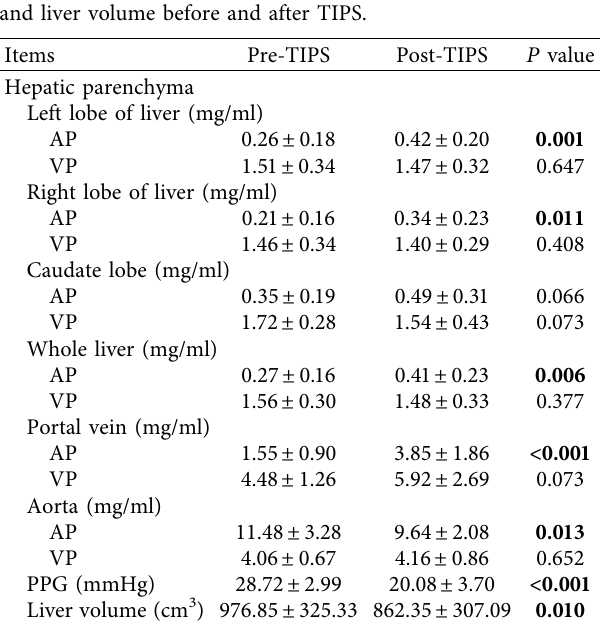
Table 2: Comparisons of iodine density, portal pressure gradient, and liver volume before and after TIPS.